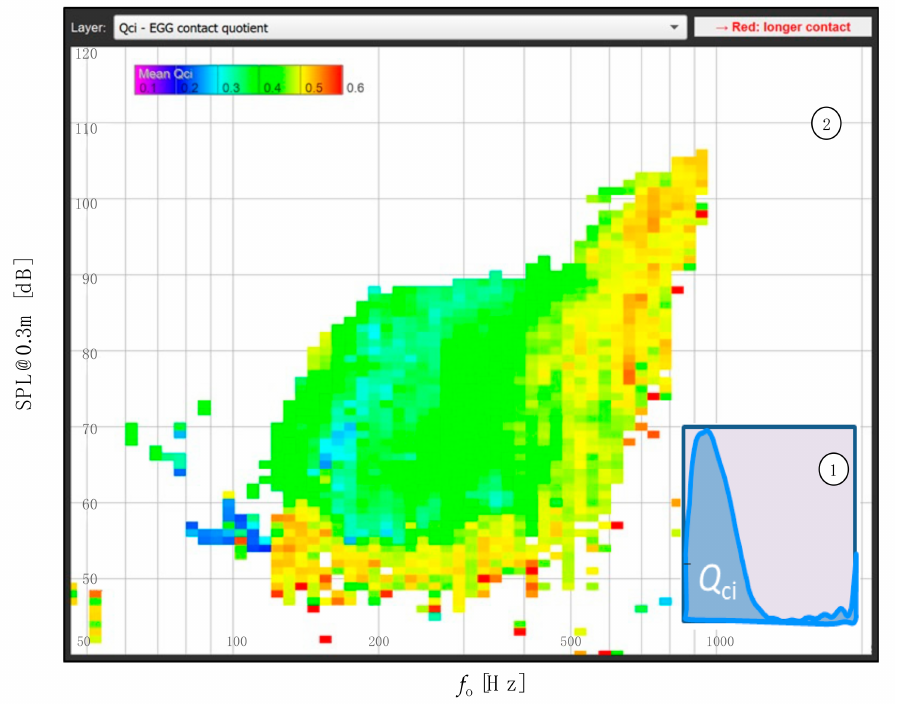
Figure 9. Typical voice map displayed in FonaDyn, showing sound pressure level (SPL) as a function of fundamental frequency ( f o ) for the metric of contact quotient by integration ( Q ci ): (1) Electroglotto- graph (EGG) shape showing the calculation of Q ci ; (2) Real-time voice map of a female singer. Contact quotient by integration can be used to assess the students’ vocal